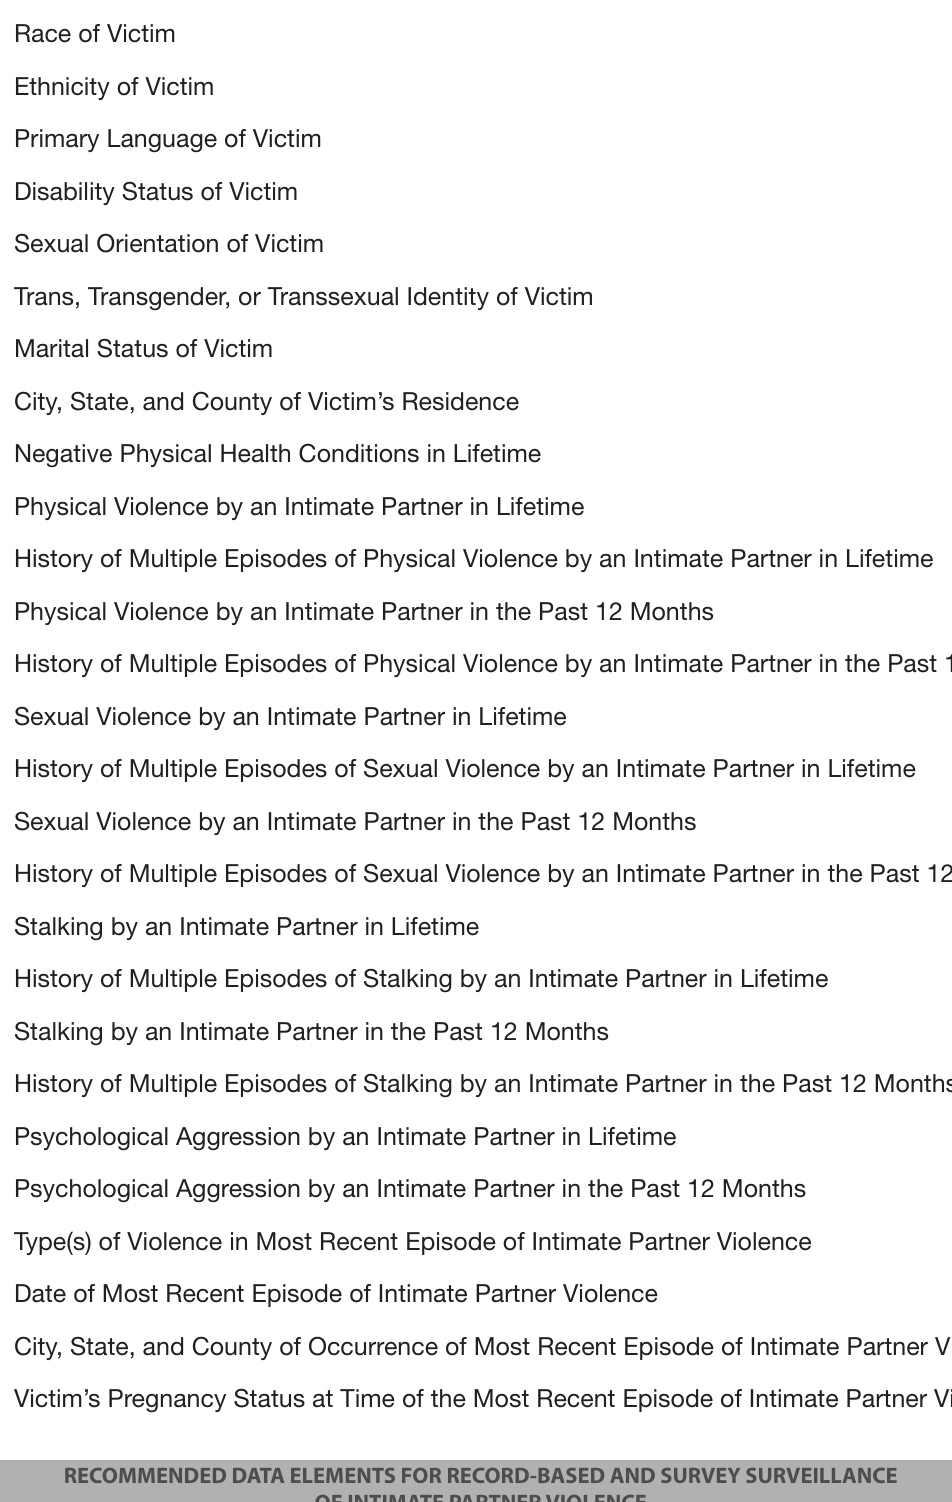
23RECOMMENDED DATA ELEMENTS FOR RECORD-BASED AND SURVEY SURVEILLANCE OF INTIMATE PARTNER